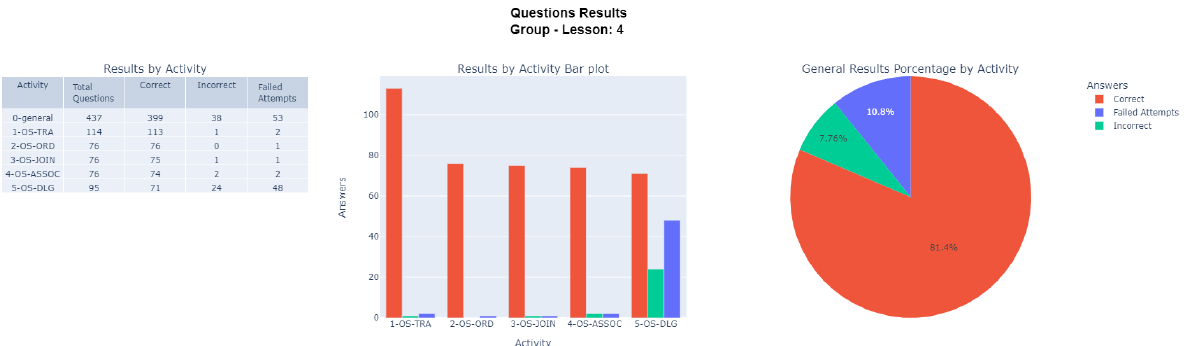
Figure 12. Group and lesson results.